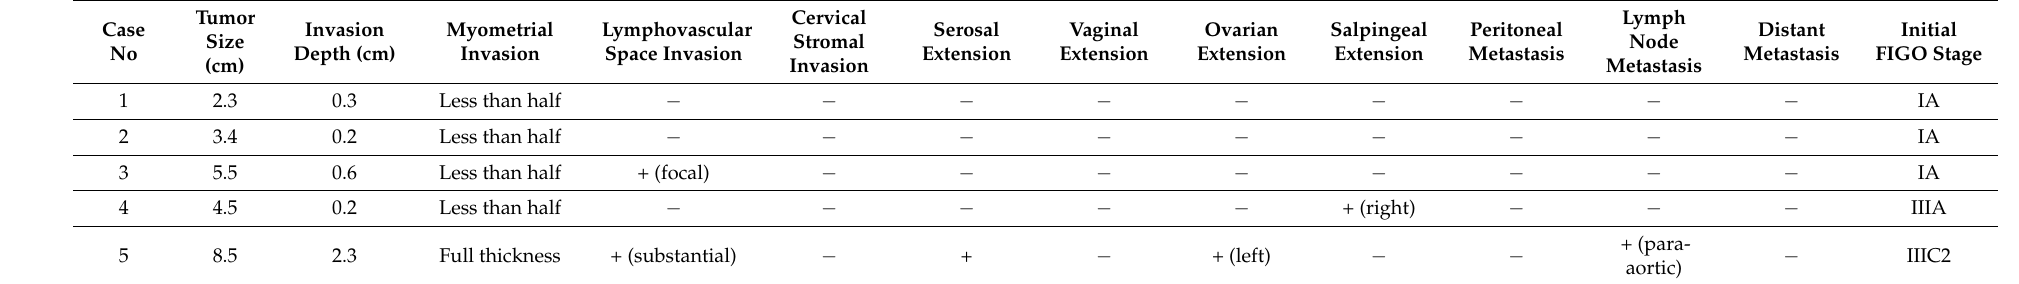
Table 2. Pathological characteristics: staging parameters.